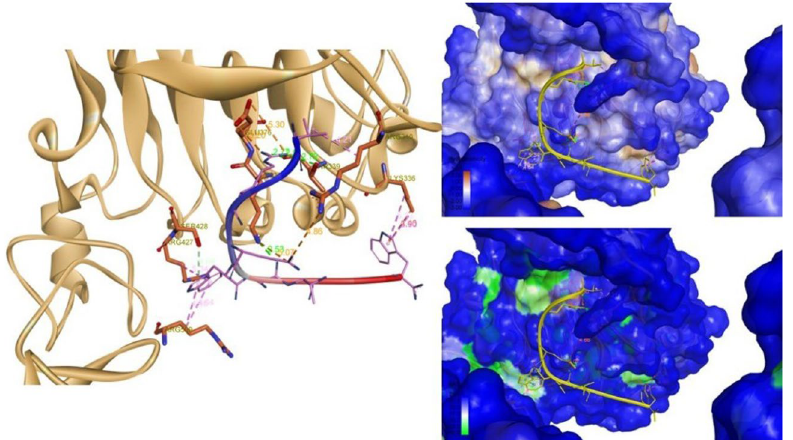
Figure 6. Inter-molecular interactions in the EGFRvIII–VLGREEWSTSYW complex. The peptide is strongly bound to the protein using Arg 4 to Thr 339. Trp 7 binds to Ser 428 and, Ser 8 to Lys 375. There are several hydrophobic interactions holding the peptide to the hydrophobic pockets on both ends of the peptide.